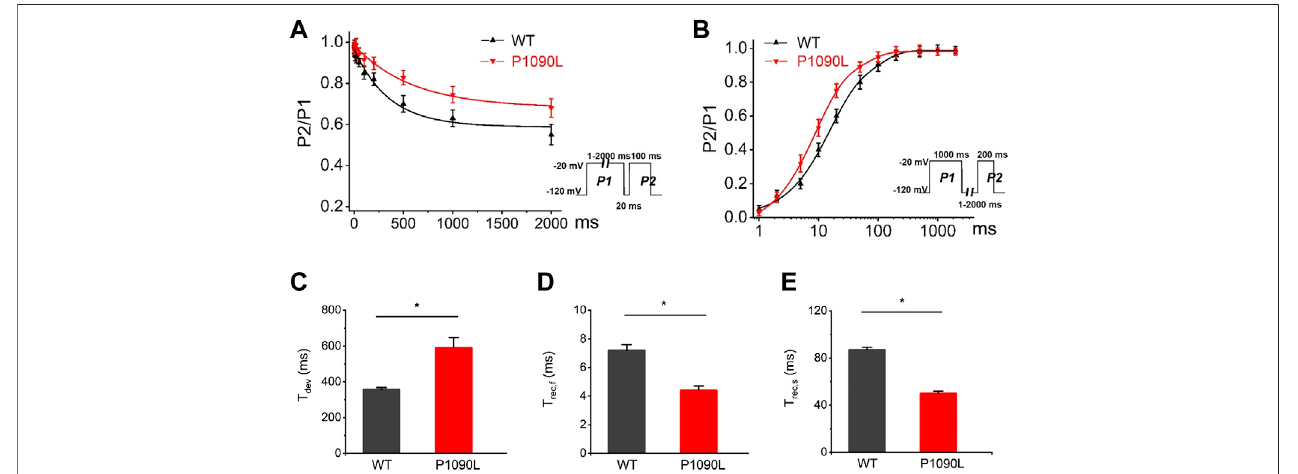
FIGURE 3 | Effects of P1090L mutation on the channel inactivation. (A) . Development of inactivation for WT and P1090L mutation was assessed by varying the duration of a conditioning pulse P1 (1 – 2000 ms) to − 20 mV followed by a return to -120 mV for 20 ms followed by a 100 ms test pulse P2 to − 20 mV. (B) . Recovery of inactivation for WT and P1090L mutation was assessed using insert protocol with a fi rst pulse duration of 1000 ms (P1) and a second pulse of 200 ms (P2) to − 20 mV withvarying restintervals from 1to2000 ms at − 120 mV. Curves in (A,B) are exponential function fi tsofthedatapoints, n = 8ineach group. (C) . Summary oftime constantfor development( Ʈ dev ) for WT and P1090L channel. (D) . Summary oftime constantfor fast recovery ( Ʈ rec,f ) for WT and P1090L. (E) . Summary oftime constant for slow recovery ( Ʈ rec,s ) for WT and P1090L. Data are presented as the mean ± SEM. * p <